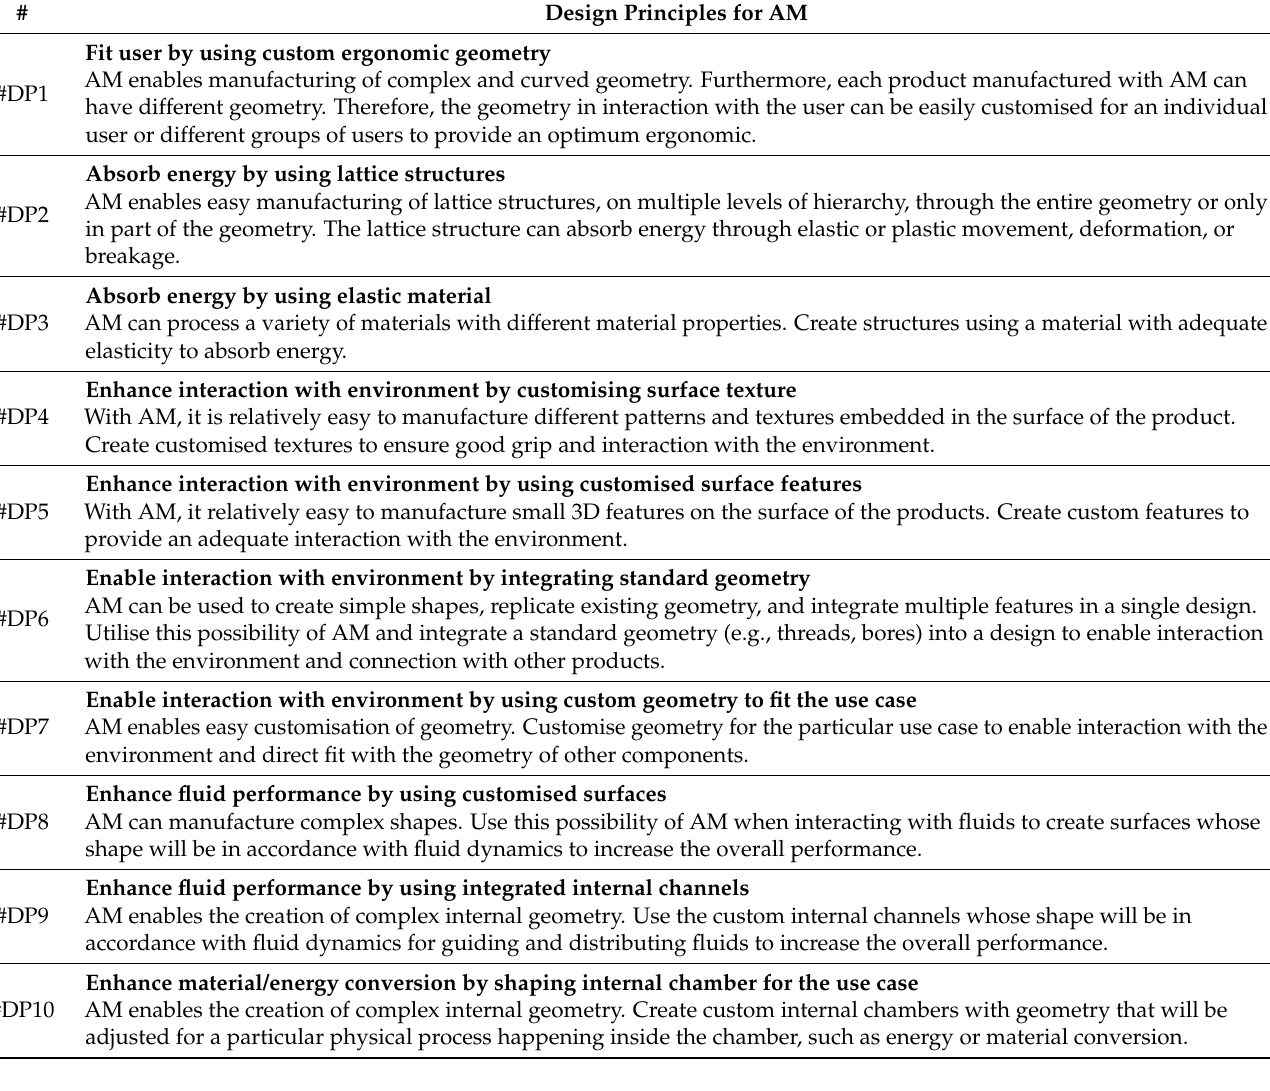
Table 1. List of derived DPs for